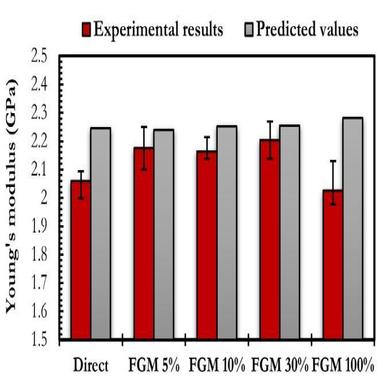
Comparison of predicted Young's moduli of interface patterns in comparison with experimental test results.